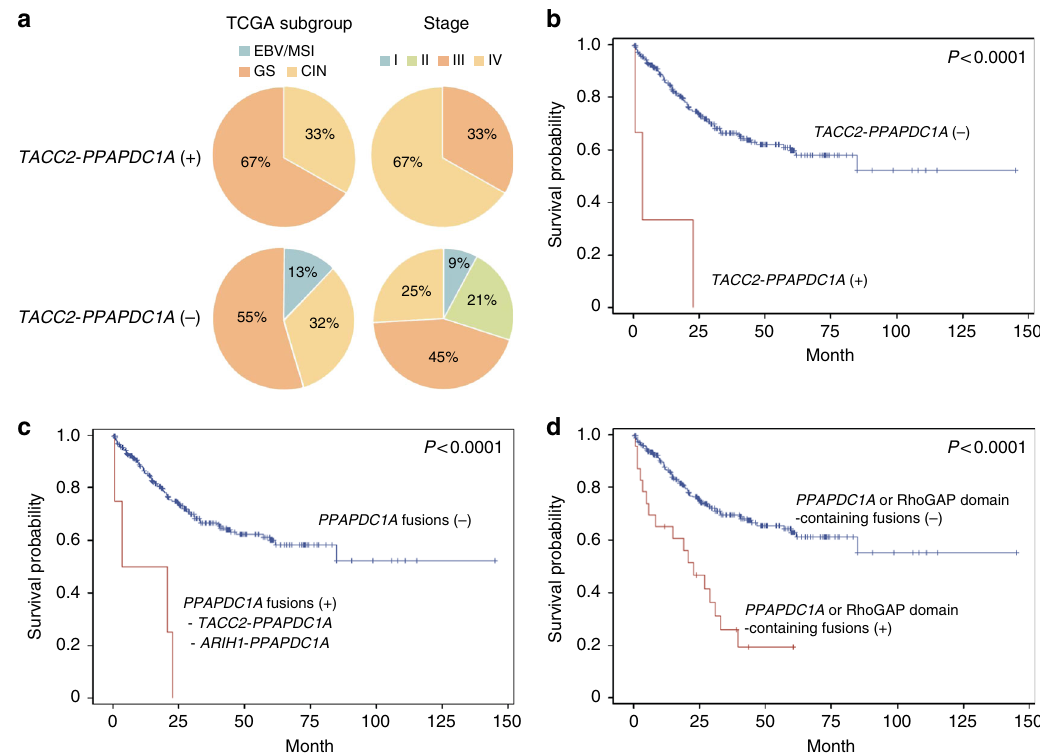
Fig. 7 Clinical implications of the TACC2-PPAPDC1A fusion in the sequenced dataset (n = 305) ( a ) Stage at the time of diagnosis and TCGA subgroups in patients with or without TACC2-PPAPDC1A . TCGA subgroup was determined only in DGCs with available SNP6.0 data. ( b ) Kaplan-Meier curves for the overall survival of three patients with DGCs expressing TACC2-PPAPDC1A and those without (n = 302). Their median survival times were 3.5 months and not reached, respectively (P < 0.0001, log-rank). ( c ) Kaplan-Meier curves for the overall survival of four patients with DGCs expressing PPAPDC1A fusions and those without (n = 301). Their median survival times were 12.1 months and not reached, respectively (P < 0.0001, log-rank; HR, 6.6 [95% CI, 2.4 ‒ 18.1]). ( d ) Kaplan-Meier curves for the overall survival of 23 patients with the PPAPDC1A or RhoGAP domain-containing fusions and those without (n = 282). Their median survival times were 22.8 months [95% CI, 5.7 ‒ 33.0] and not reached, respectively (P < 0.0001, log-rank; HR, 3.4 [95% CI, 2.0 ‒ 5.7])